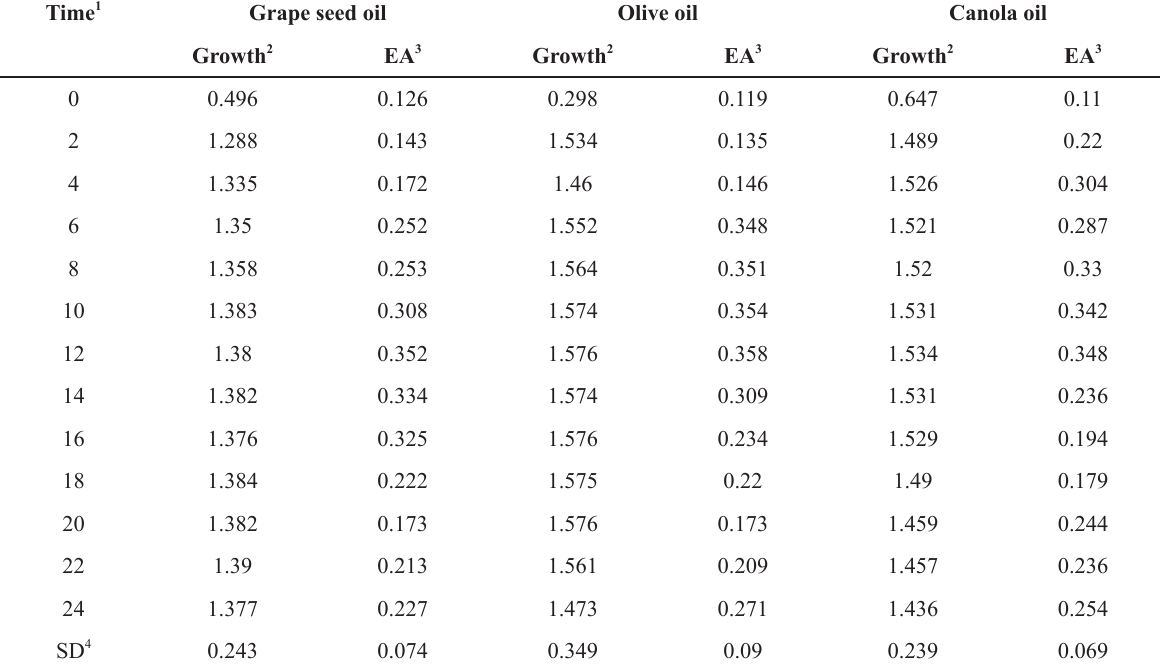
Comparison among cell growth of isolate G40 and its enzymatic activity. Experiment was performed in the bioreactor, at 30 ºC for 24 h.